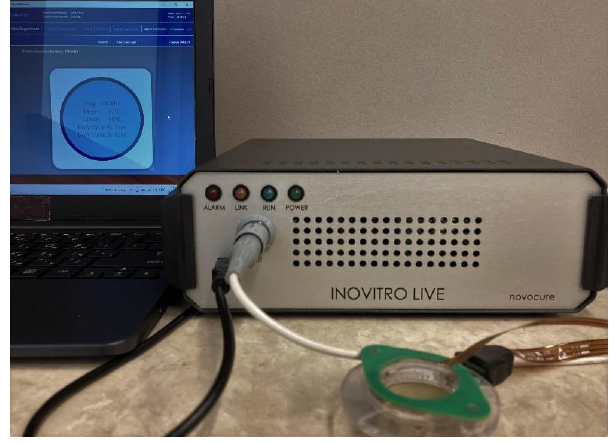
Figure 1. A digital photograph of the Novocure inovitro™ live system, with all four main compo- nents shown.